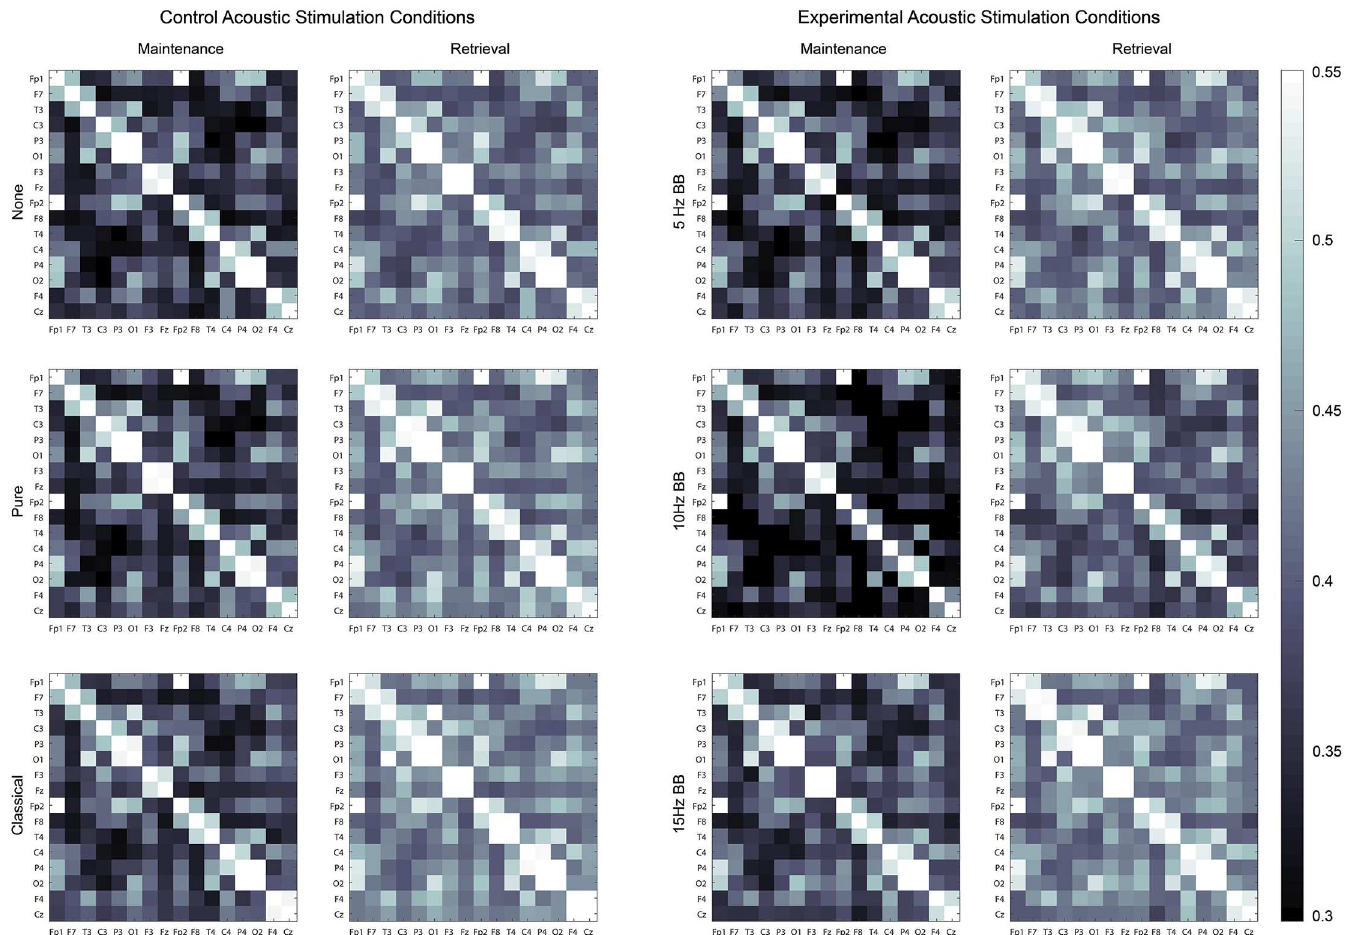
Fig 4. Theta band PLV connectivity network weight matrices. For each weight matrix, the diagonalis always equal to one.